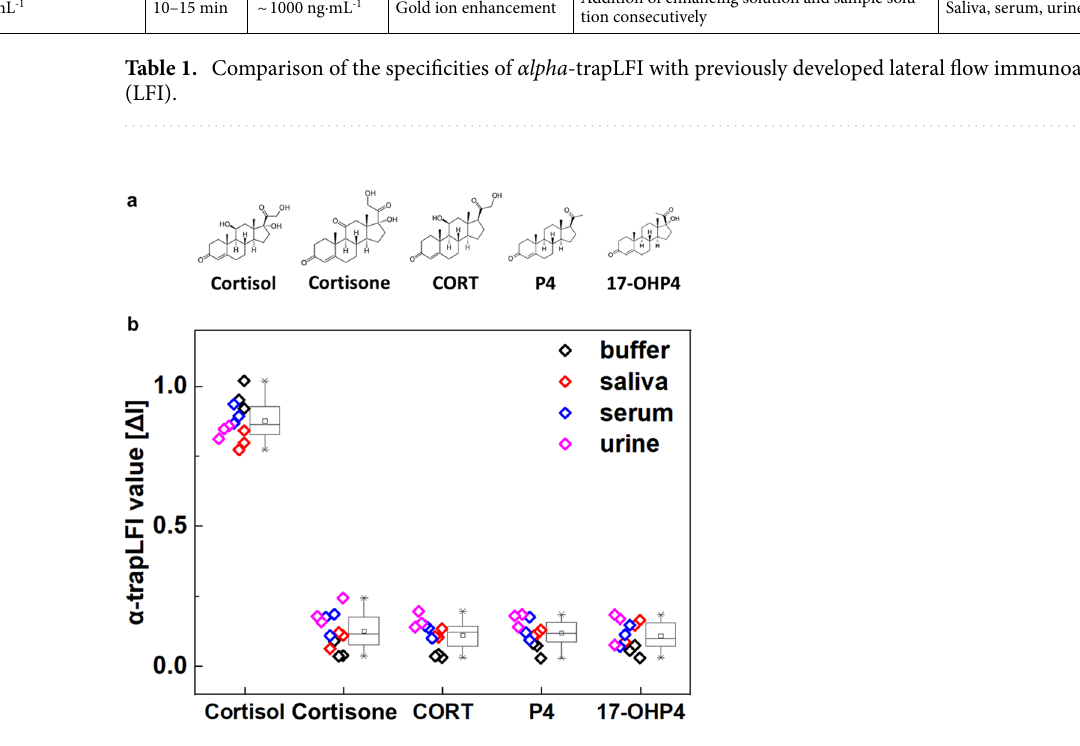
Figure 6. Cross-reactivity of α -trapLFI sensor in human bodily fluids. a Structure of cortisol and other steroid hormones. b Selectivity results comparing cortisol and other steroid hormones. All images were obtained using a ChemiDoc XPS + imaging system (Bio-Rad), and the band intensities were measured using Image Lab software (version 6.1, https:// www. bio- rad. com/ en- uk/ produ ct/ image- lab- softw are? source_ wt= image labso ftware_ surl& ID= KRE6P 5E8Z). Error bars indicate the standard deviation from three independent